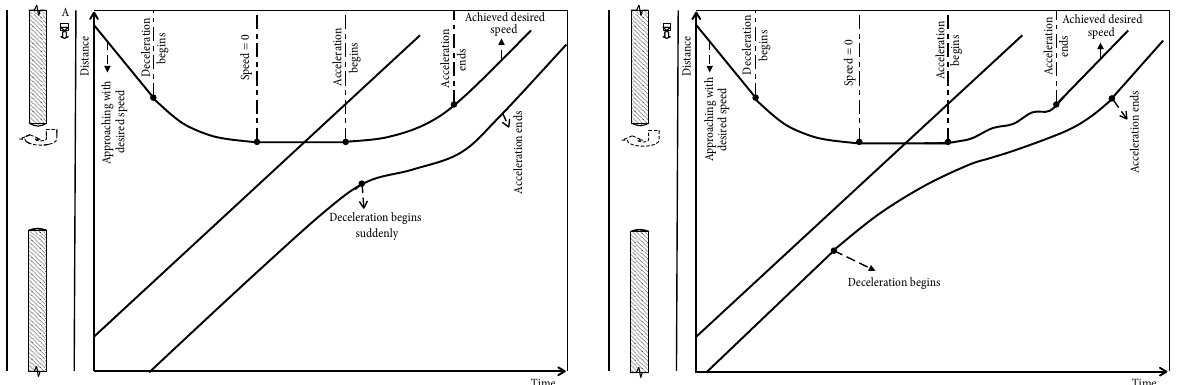
Fig. 7. Time–distance diagram for AM Fig. 8. Time–distance diagram for